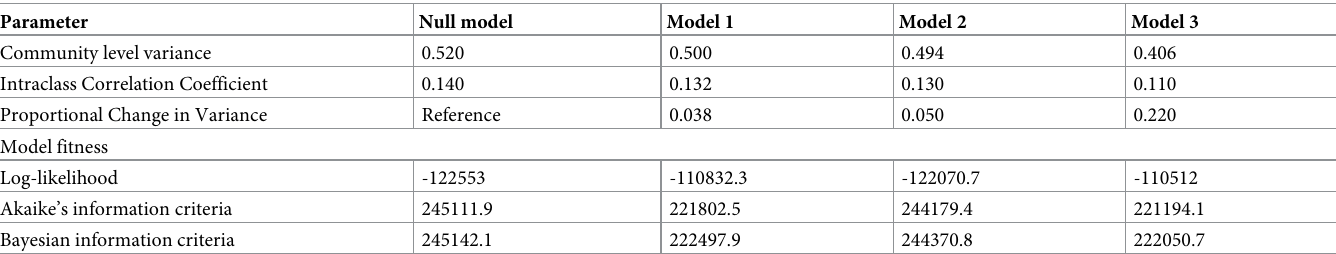
Table 4. The random effect model in assessing the factors associated with unmet need for family planning in sub-Saharan